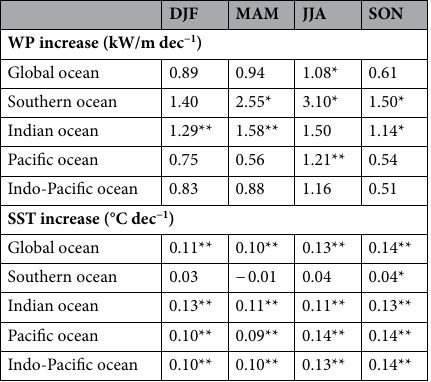
Seasonal relationships between wave power and SST over indo‑pacific ocean. Figure 2 pro-